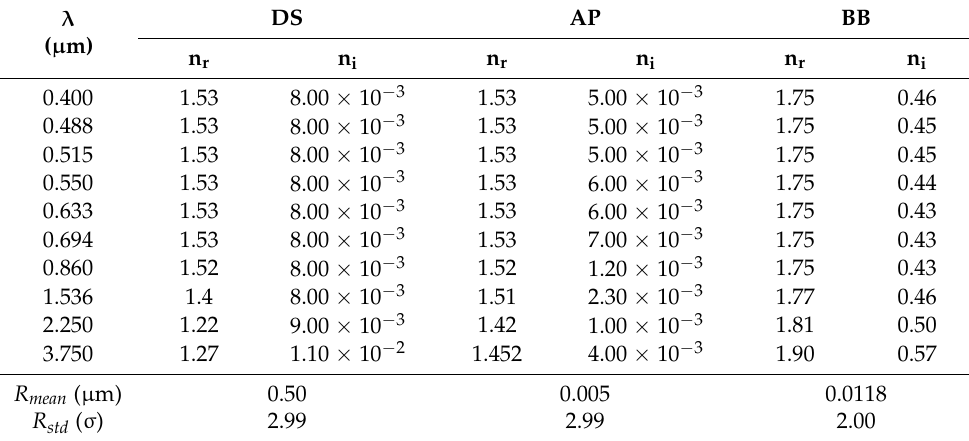
Table 1. Spectral complex indices of refraction and parameters of lognormal size distributions used for DS, AP and BB aerosols from the World Meteorological Organization (WMO)’s recommendations (WMO-WCP112, the experiment dataset in this study) DS: mineral dust; AP: anthropogenic pollutants; BB: biomass